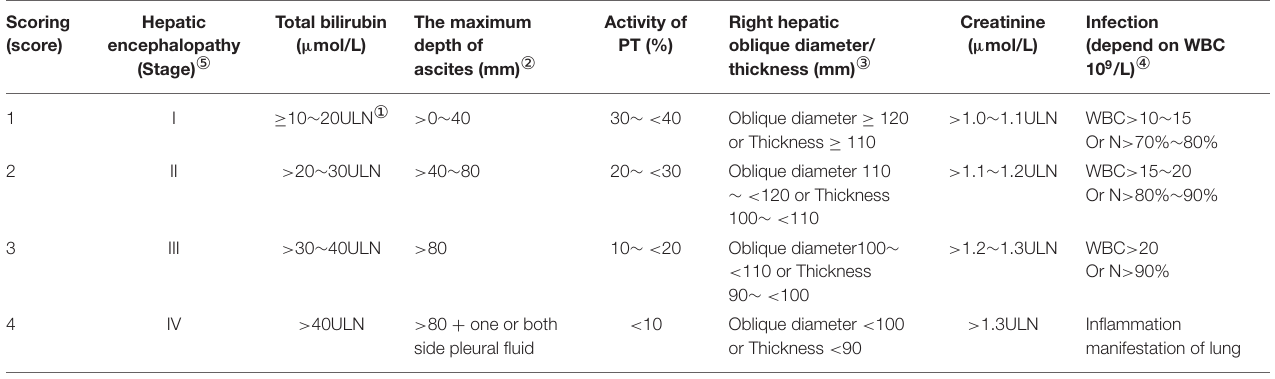
TABLE 1 | Assigned scores of the Chinese scoring system. Scoring (score)